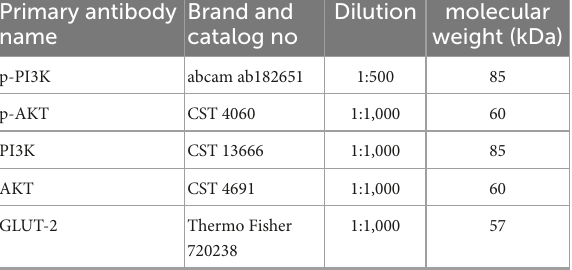
TABLE 2 Primary antibody information in western blotting